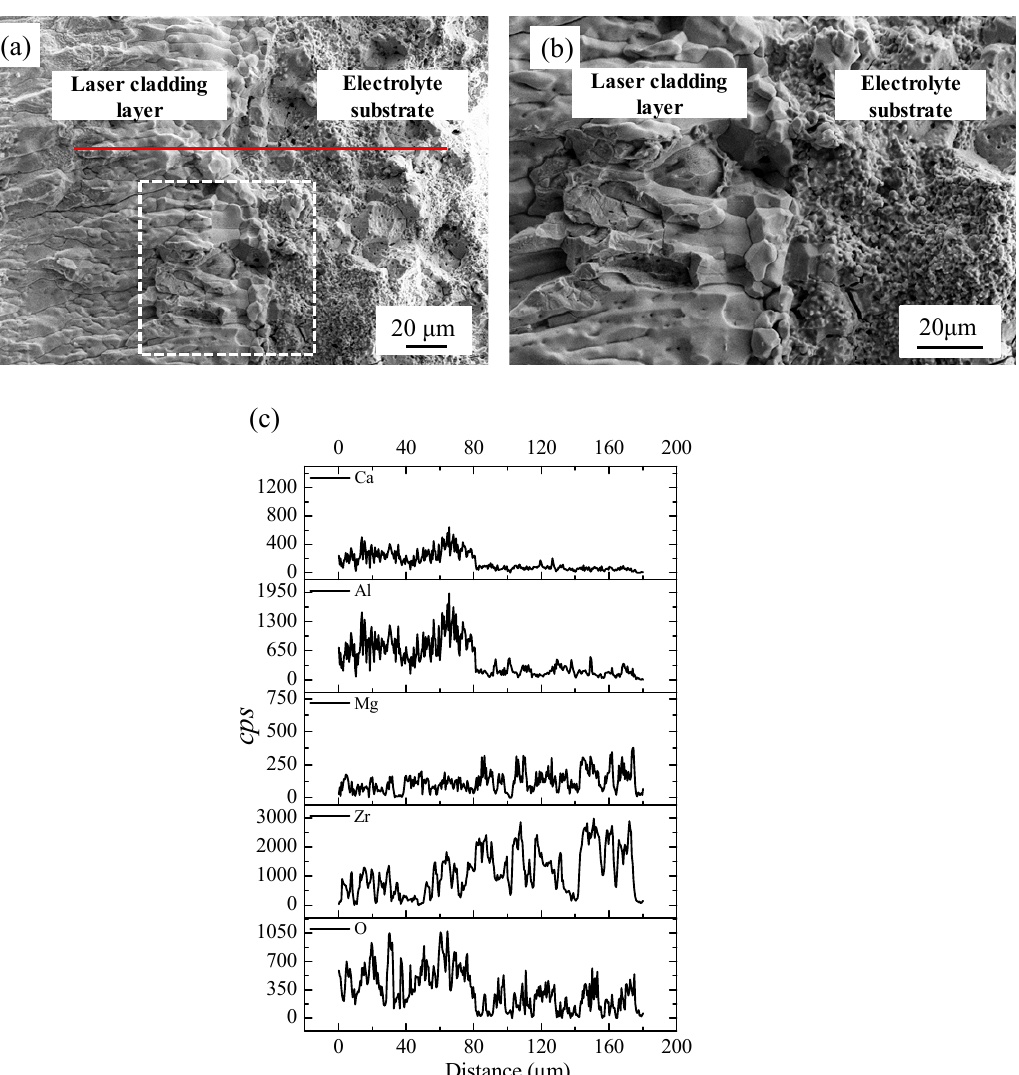
Figure 3. ( a , b ) Scanning electron microscope (SEM) micrographs and ( c ) line scan of the cross-section Figure 3. (a, b) Scanning electron microscope (SEM) micrographs and (c) line scan of the of the fabricated cross-section of the fabricated sample.